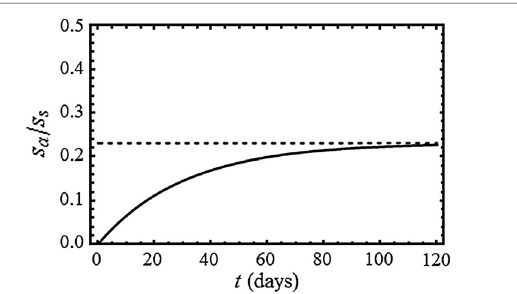
Fig. 9 Surface displacement generated by afterslip following the 2011 Tohoku-Oki earthquake, according to the model. The surface displacement is estimated over a time interval of 120 days. It is nor- malized to the coseismic surface displacement s